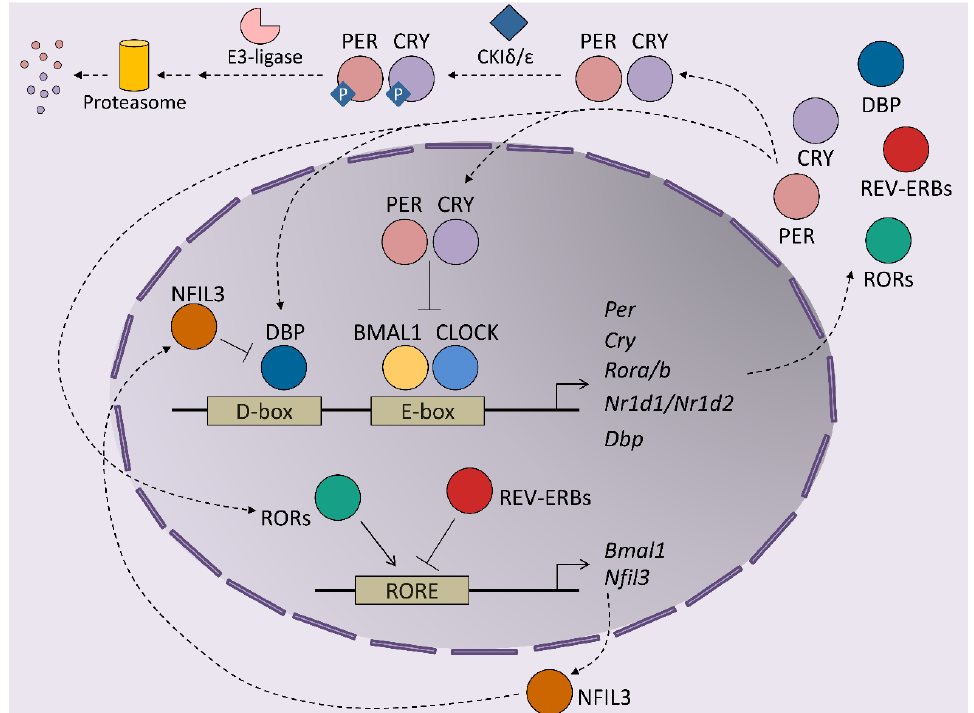
Figure 1. Transcriptional/translational feedback loops sustain the mammalian circadian clock. The cycle is initiated by the induction of expression of the clock genes Per, Cry, Rora/b, Nr1d1/2 and Dbp by the BMAL1-CLOCK complex. The first regulatory loop is mediated by PER and CRY proteins that translocate to the nucleus to inhibit the activity of the BMAL1-CLOCK complex, thus repressing their own expression. To restore the cycle, PER and CRY proteins in the cytoplasm are phosphorylated by CKIε/δ protein kinases to target them for degradation by the proteasome. A second loop regulates the expression of Bmal1 by the nuclear receptors REV-ERBs (encoded by Nr1d1/2) and RORs (encoded by Rora/b), which repress and induce Bmal1 expression, respectively. Finally, in a third loop, the clock activator DBP (D-box binding protein), which induces the expression of clock component genes, is inhibited by NFIL3, whose transcription is, in turn, controlled by REV-ERBs and RORs. These three interconnected regulatory loops enable the rhythmic expression of the core clock genes and further sustain the cycling of the transcriptome.